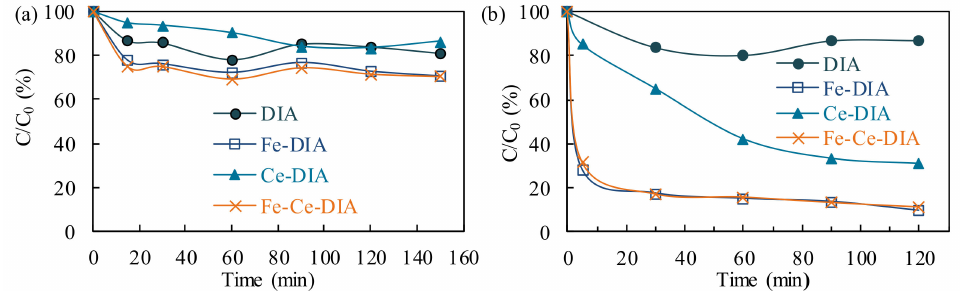
Figure 5. Tetracycline adsorption by DIA, Fe-DIA, Ce-DIA, and Fe-Ce / DIA ( a ); tetracycline degradation by adding persulfate ( b ). Conditions: (Tetracycline) = 200 mL, 50 mg / L, (Catalyst) = 0.02 g, (Persulfate) = 0.134 g, T = 37 ◦ C, 150